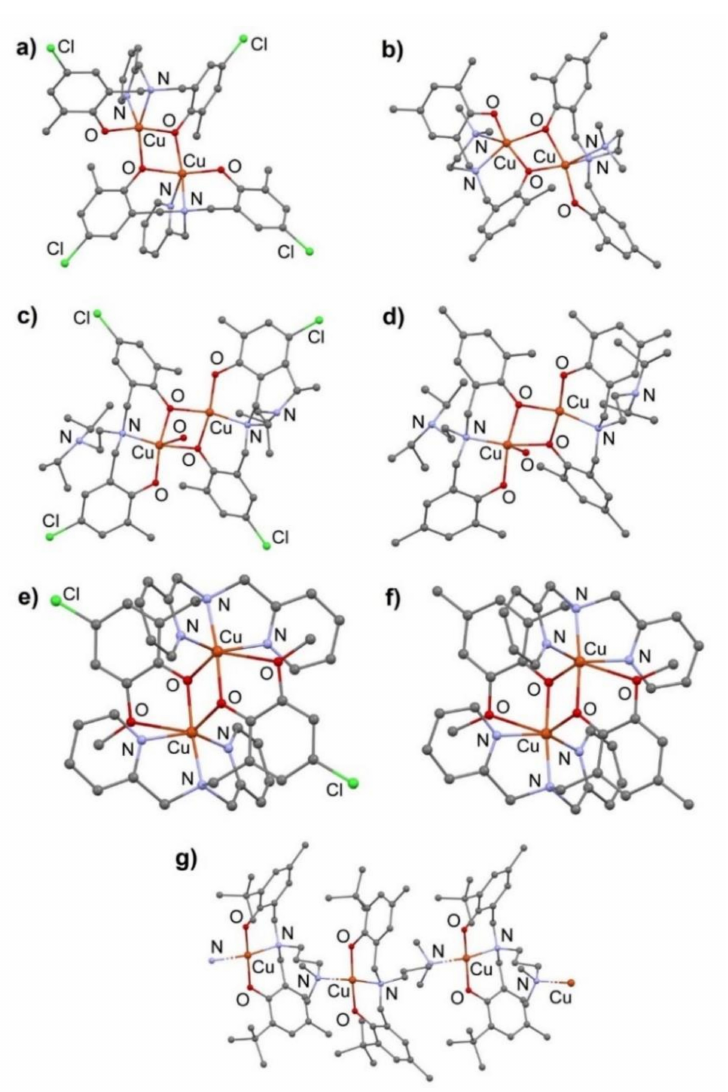
Figure 2. Perspective views of 1, 2, 5 – 8 , and 10 represented as ( a – g ),